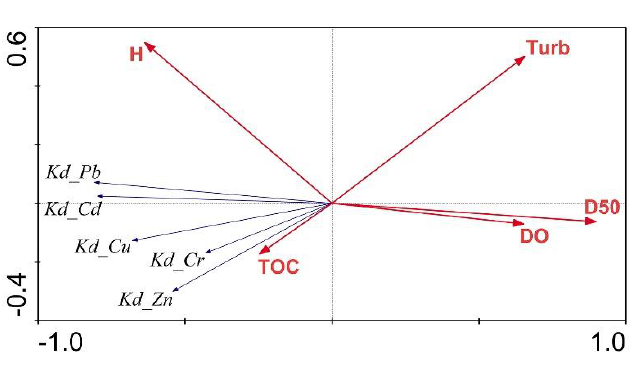
Figure 10. Redundancy analysis (RDA) analysis results of the K d values and environment variables.